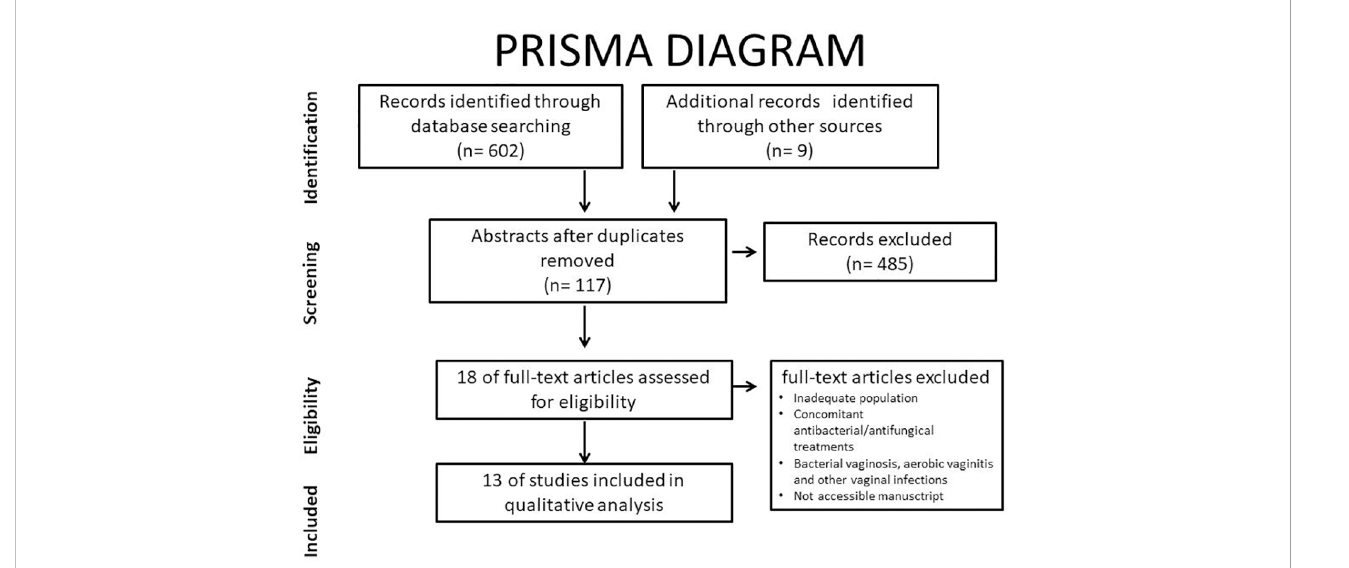
FIGURE 1 Preferred Reporting Items for Systematic Reviews and Meta-Analyses (PRISMA)